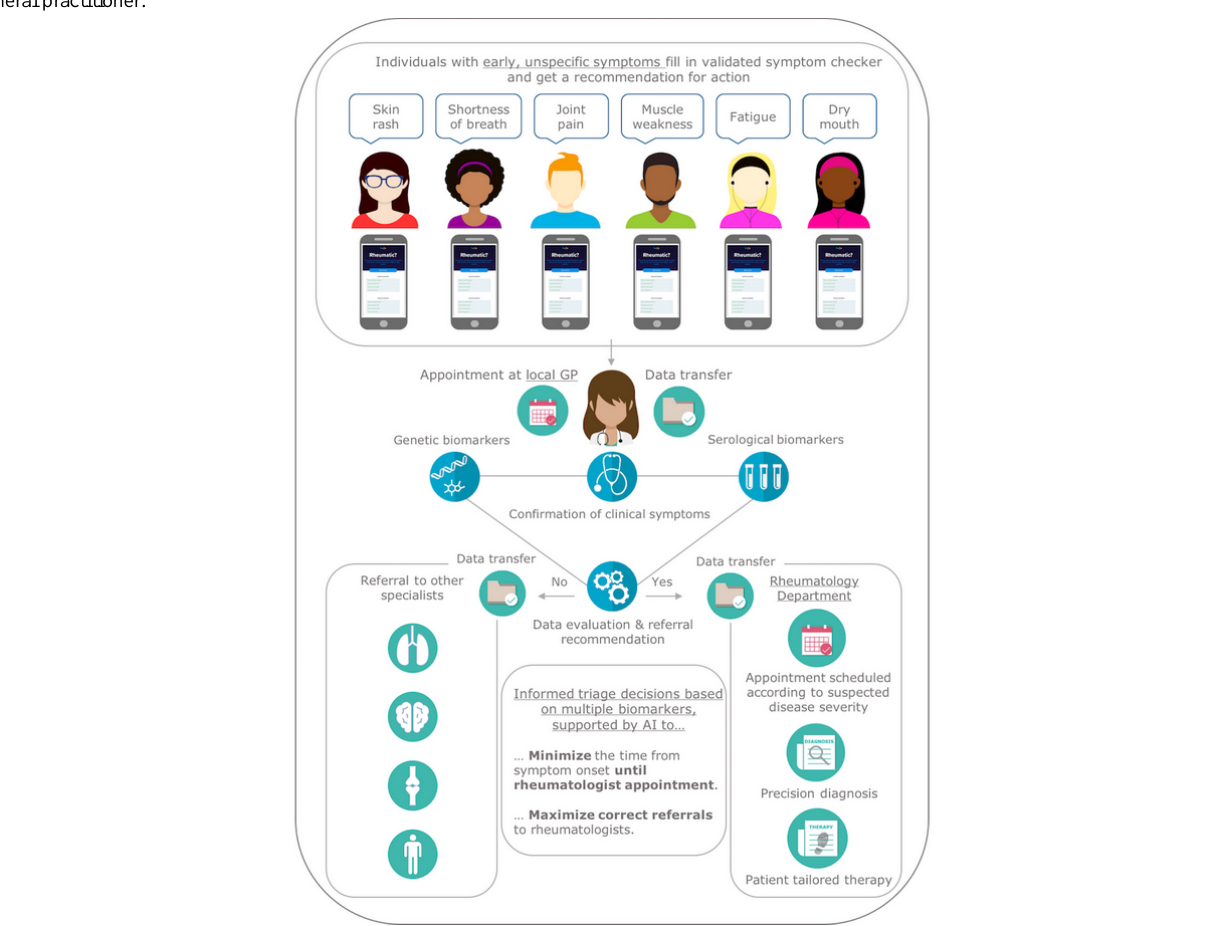
Figure 2. Shorter patient journey and more efficiency in health care with JPAST (Joint Pain Assessment Scoring Tool). AI: artificial intelligence; GP: general